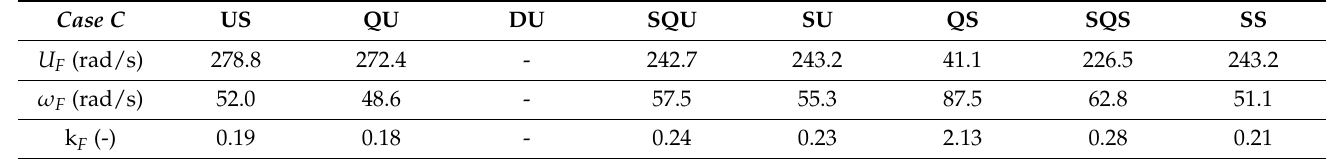
Table 6. Flutter analysis results for Case C using different aerodynamic models; elastic axis at aerodynamic centre. Case